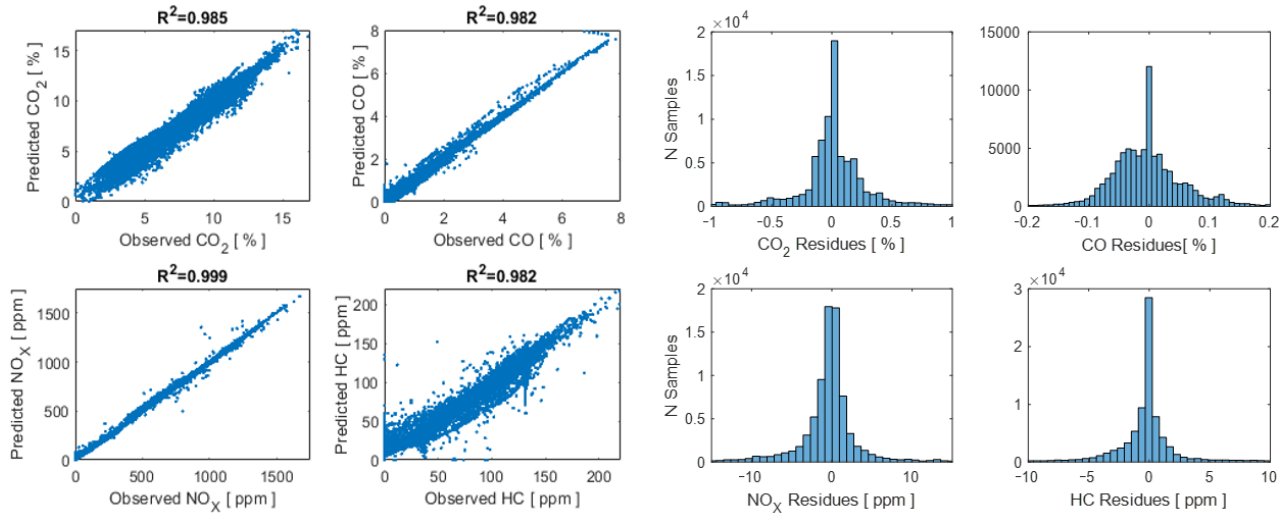
Figure 8. Validation of the ANN with the data from the RDE test Route